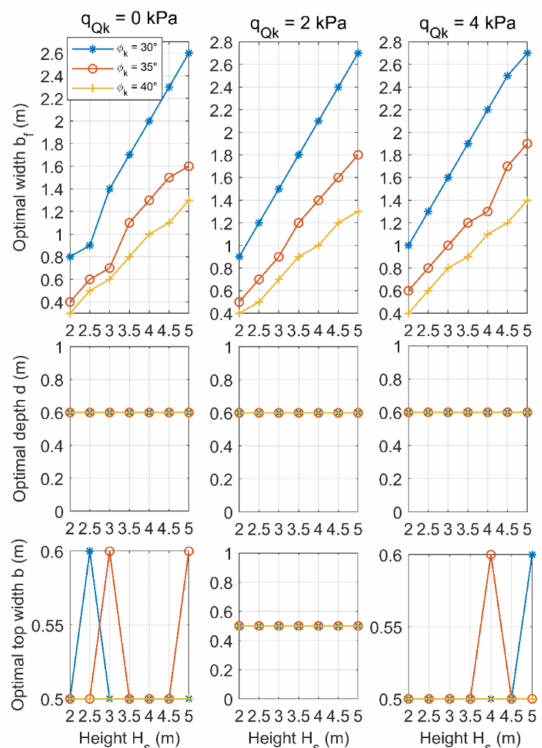
Figure 10. Optimal design for k = 1, β = 10 ◦ and γ = 18 kN/m 3 .